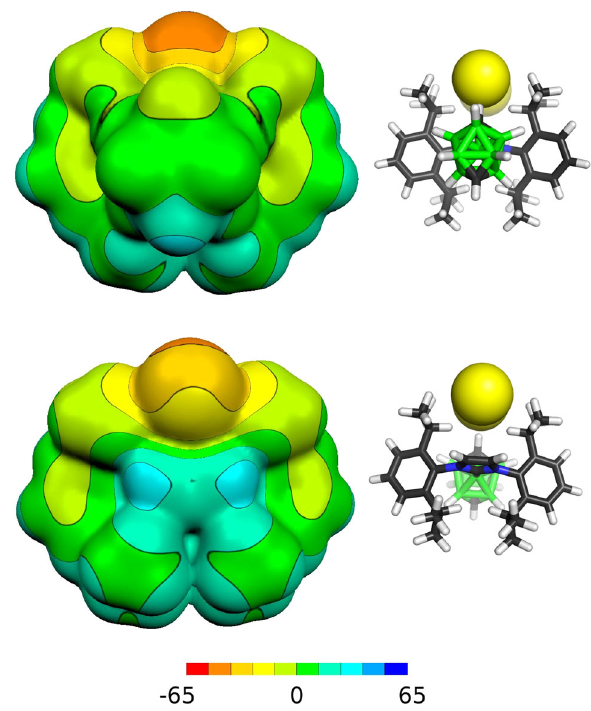
Fig. 4 Computed (B3LYP/cc-pVTZ) ESP surface for p- 2a. The colour range of the ESP in kcal/mol. The negative surface is located on HCl 2 - , the areas with the most positive ESP are the CH vertexes of the carborane cage and CH = CH fragment of the NHC.